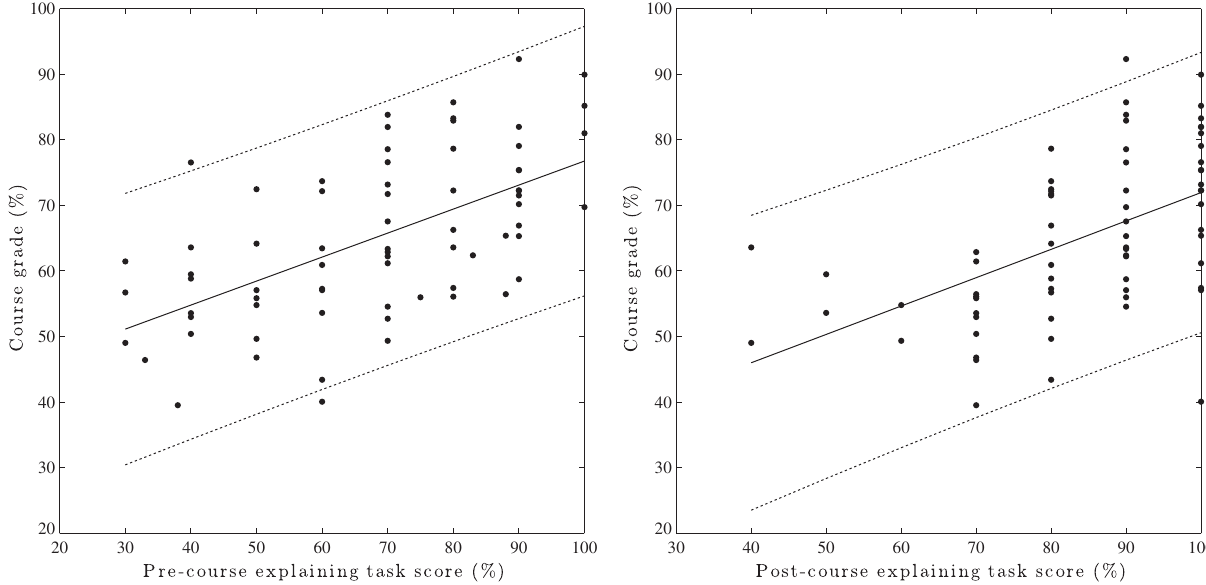
FIG. 2. Illustration of the linear relationship between final course grades and precourse scores (left panel) and postcourse scores (right panel) on the explaining task. In each plot, the solid line represents the best-fitting linear model for the data, while the dotted lines represent 2 σ prediction bounds for the